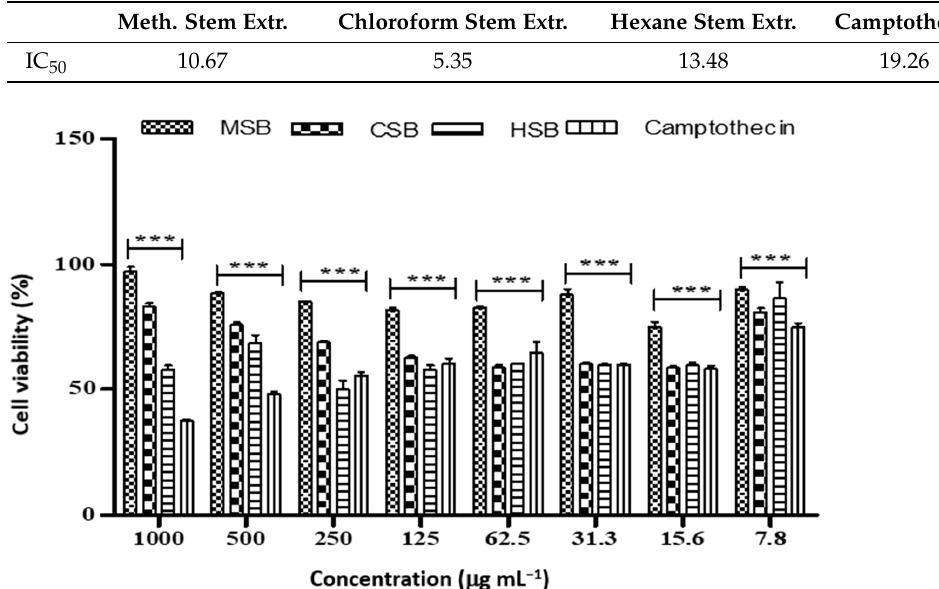
Figure 8. Cell viability of A549 cancer cell lines treated with different concentrations of D. villosa stem extract. *** (MSB vs. Camptothecin), p < 0.001.